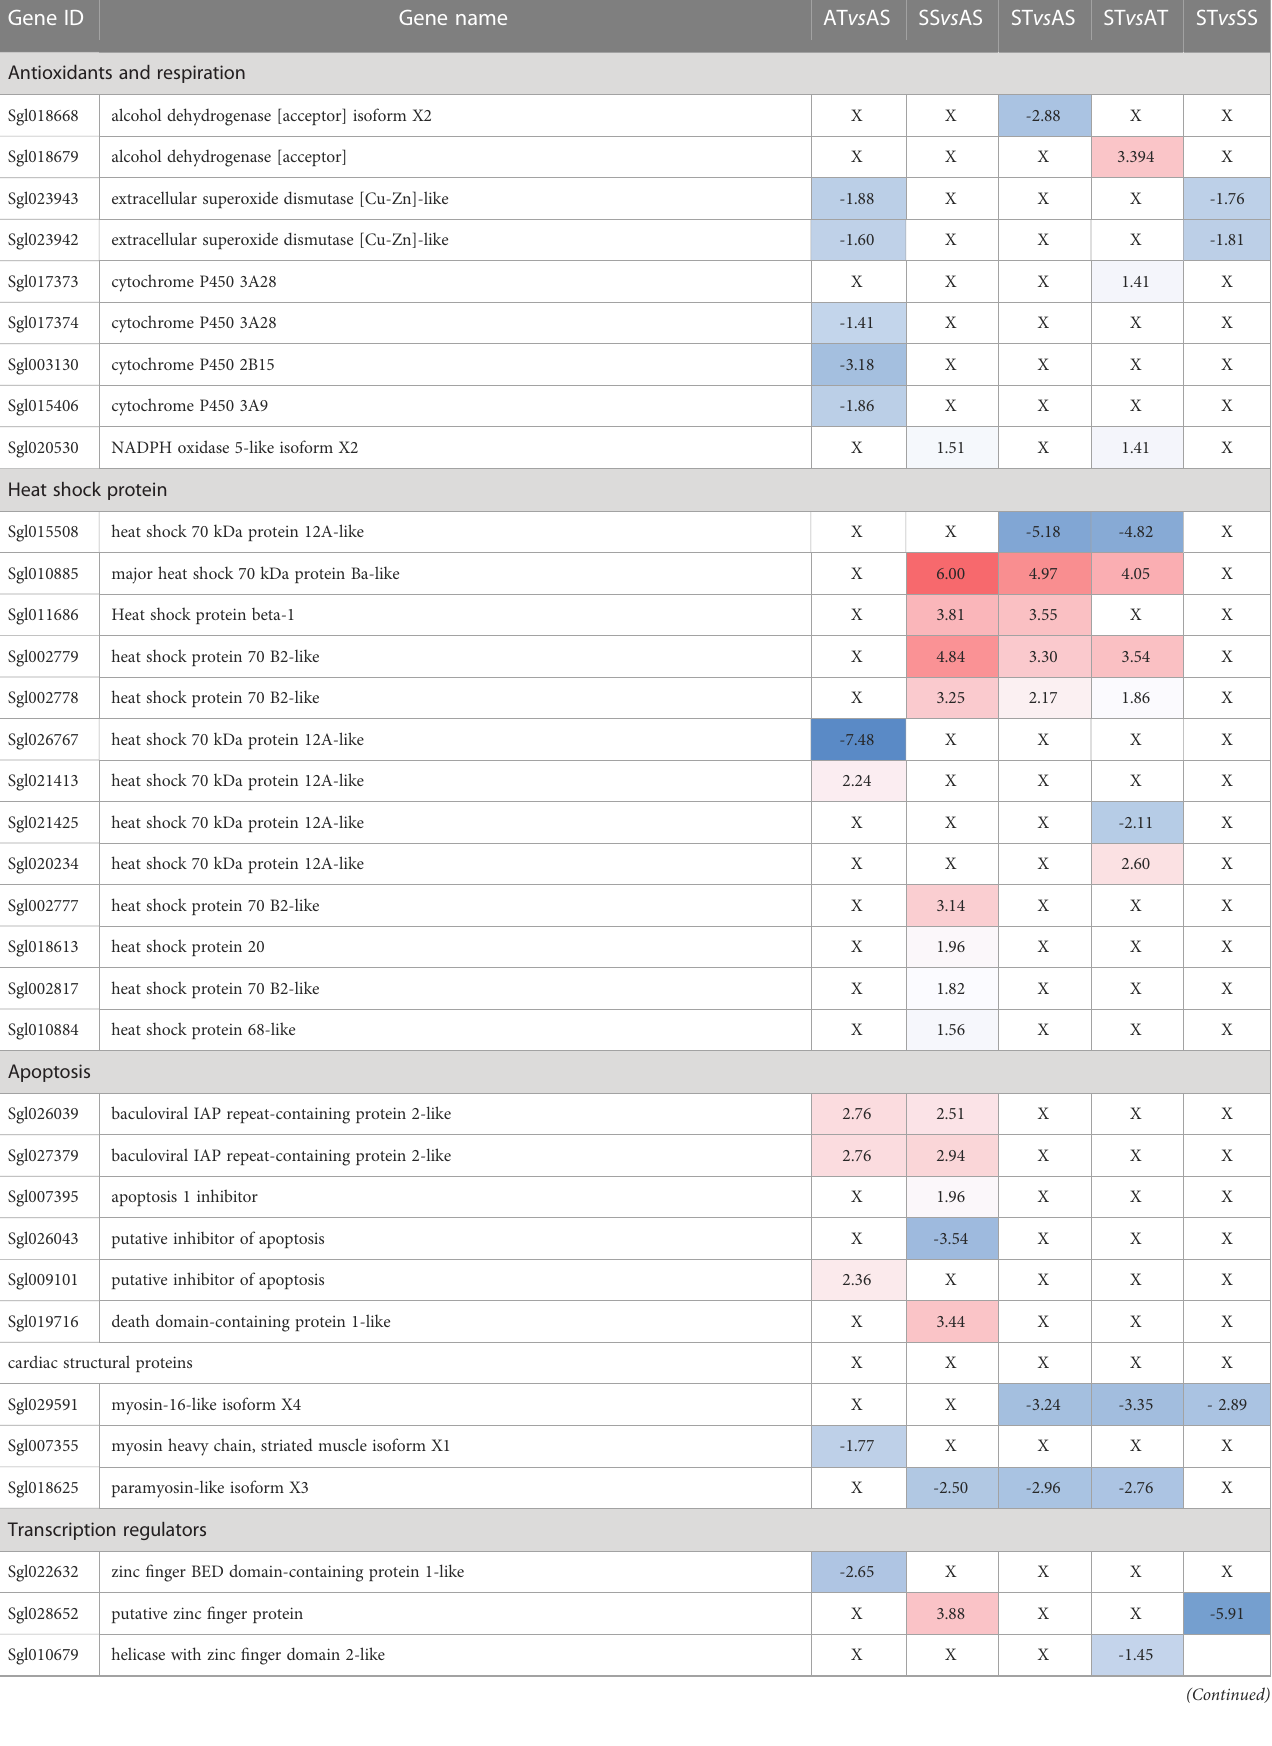
TABLE 3 The analysis of the differentially expressed genes (DEGs) related to the cellular response to stress among the treatment groups. Gene ID Gene name AT vs AS SS vs